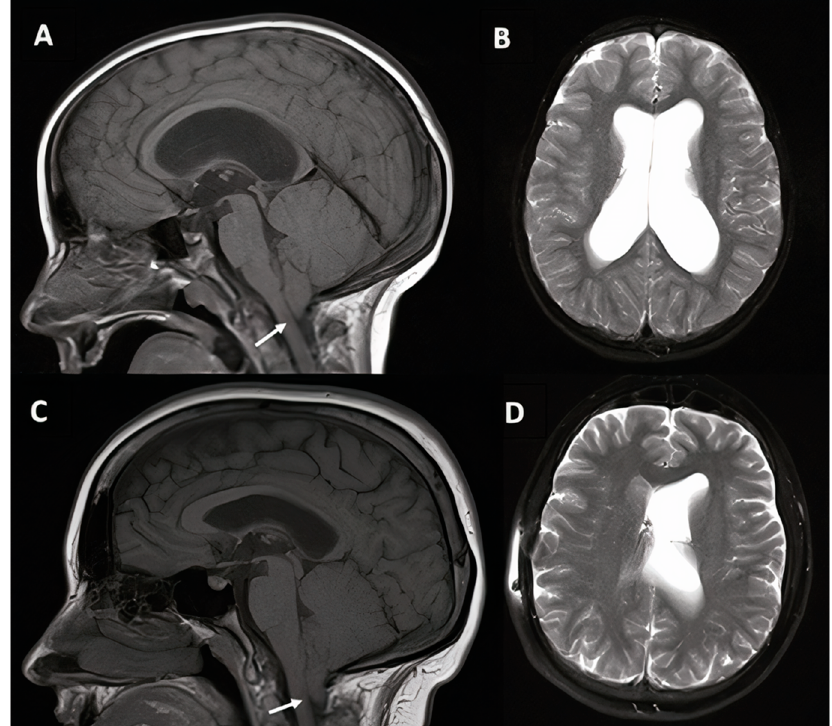
Figure 2. 6-year-old female patient with Chiari I malformation (case #1). Pre-operative ( A , B ) and 10 years post-operative ( C , D ) T1-weighted midsagittal and T2-weighted axial magnetic resonance imaging (MRI). Inferior displacement of the cerebellar tonsils below the foramen magnum consistent with Chiari malformation is indicated by the white arrows.